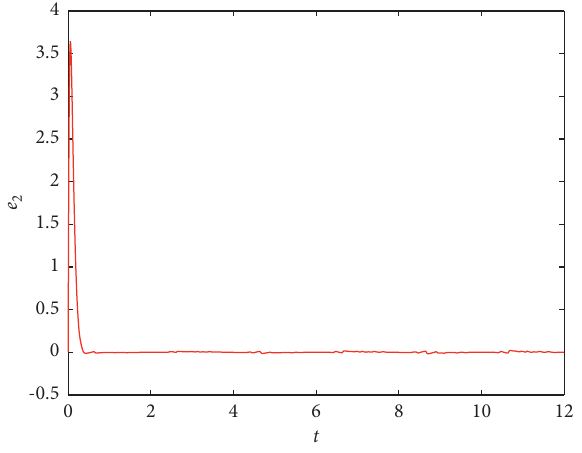
Figure 4: State error e